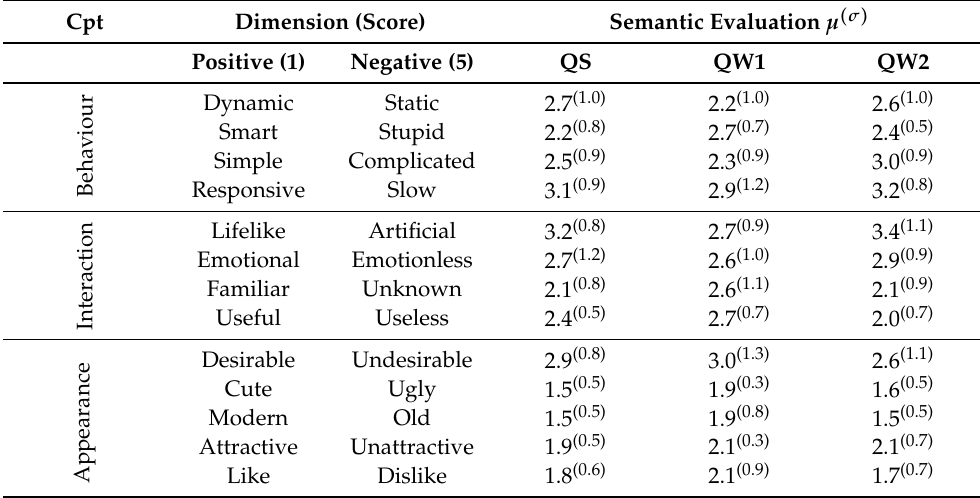
Table 1. Semantic analysis results (second experiment). Lowest score—positive adjective; highest score—negative